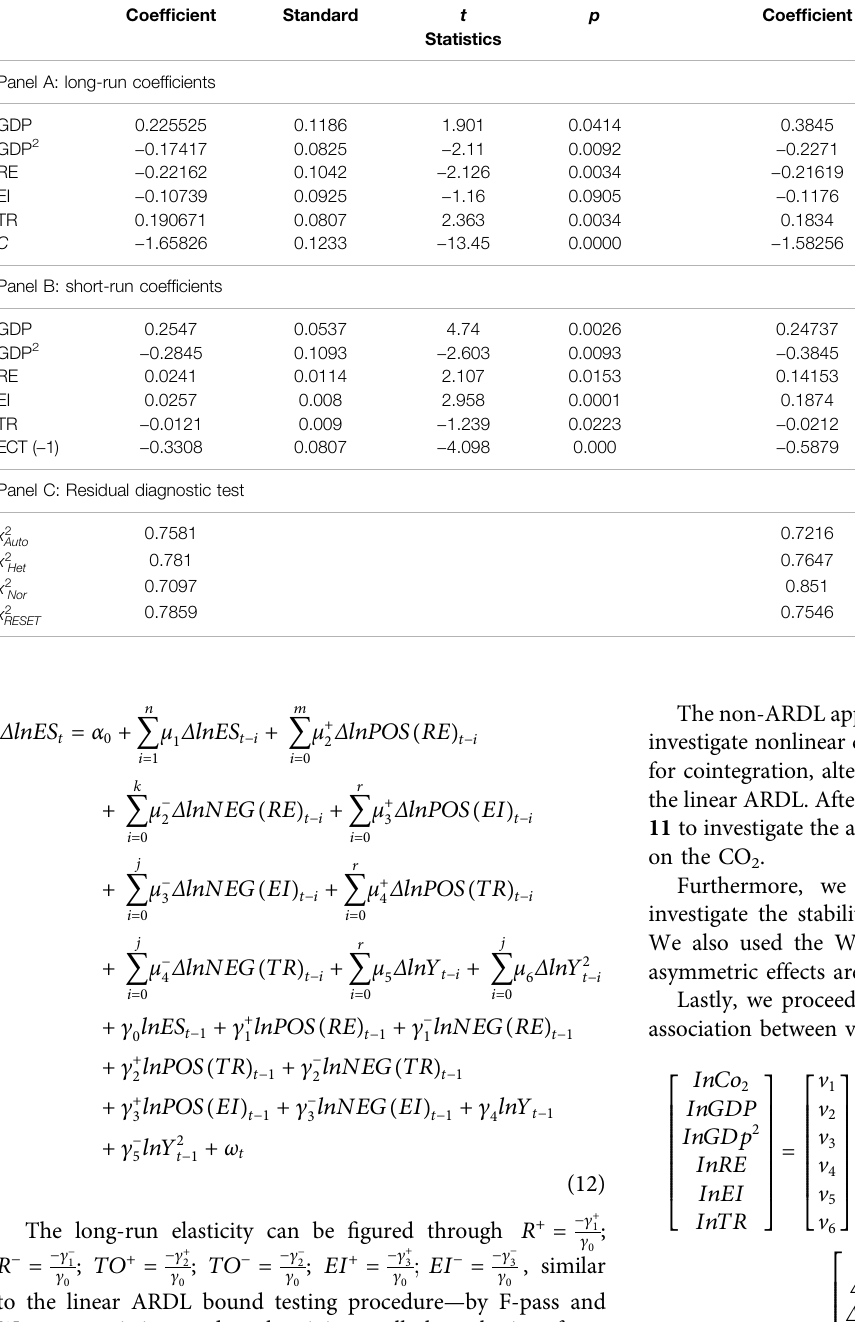
TABLE 8 | Results of long- and short-run coef fi cients with symmetry assumption. Morocco Tunisia Coef fi cient